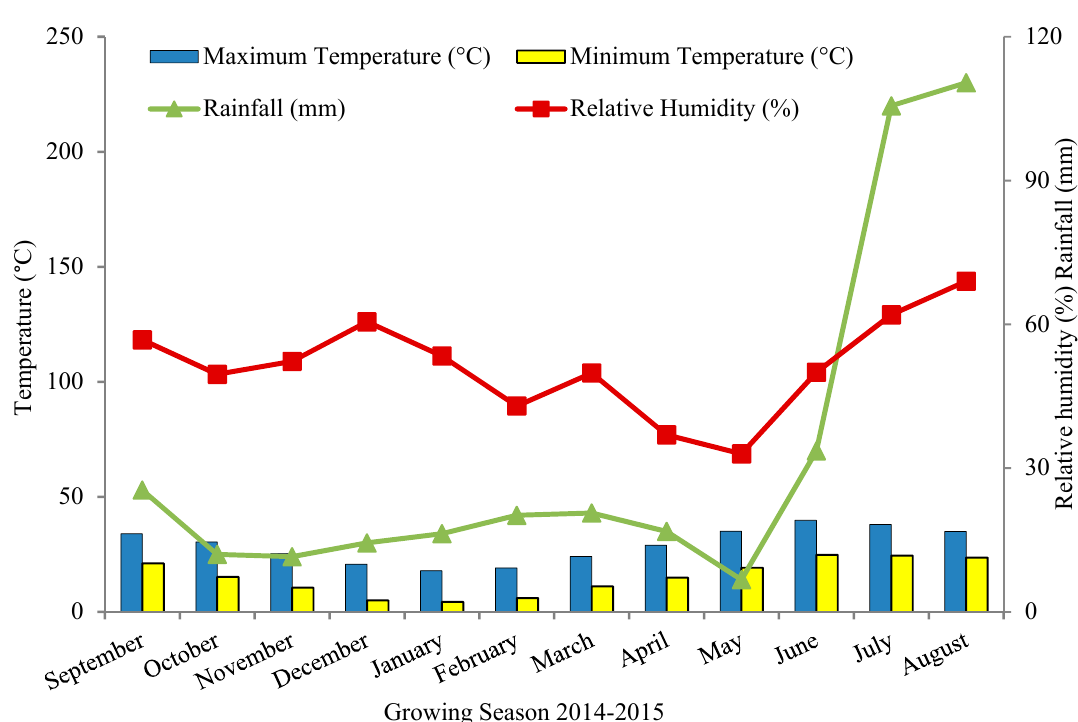
Figure 2. Meteorological data regarding average minimum and maximum temperatures (°C), monthly rainfall (mm) and relative humidity (%) of 2014–2015.